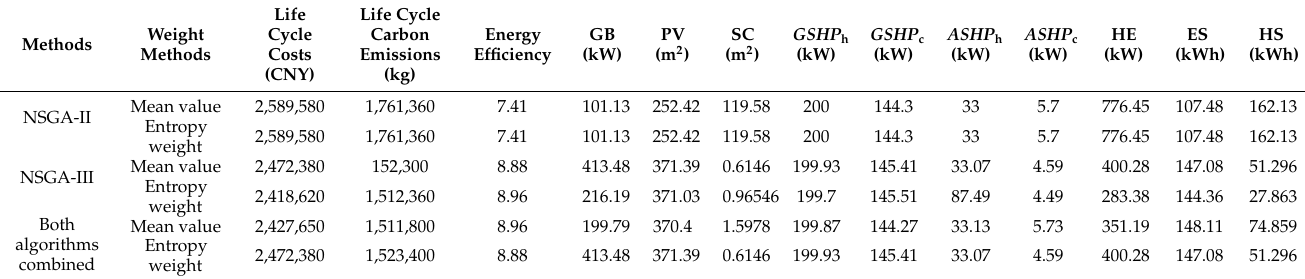
Table 5. Optimal solutions and decision